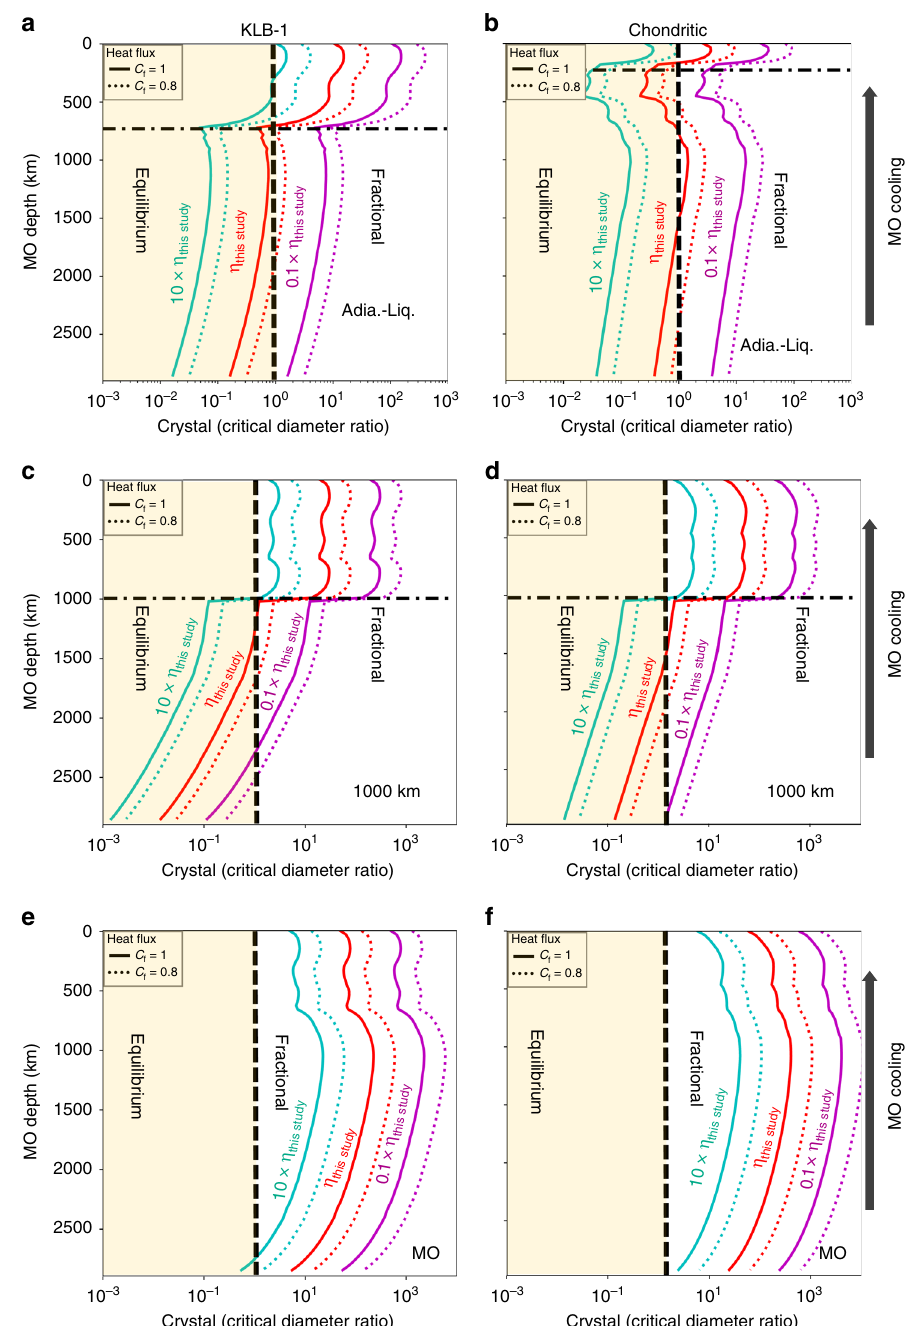
Fig. 4 Crystal/critical diameter ratio as a function of magma ocean depth. Rcc parameter calculated for KLB-1 MO ( a , c , e ) and chondritic-type MO ( b , d , f ) using bridgmanite as solid phase and a solid-melt Fe partition coef fi cient of 0.6. We considered MO viscosities of 10 (green), 1 (red), and 0.1 (blue) times the MO viscosity determined in this study. Solid or dotted pro fi les correspond to no blanketing atmosphere ( Cf = 1) or an atmosphere reducing the effective surface temperature by 20% ( Cf = 0.8, see Eq. (16)), respectively. Zones colored in yellow (Rcc lower than 1) or white (Rcc higher than 1) indicate MO expected to solidify at chemical equilibrium or through fractional solidi fi cation with sedimentation of bridgmanite, respectively. The horizontal black dashed-dotted line marks the MO-bottom depth when crystallization starts at the surface of the MO. Upper, middle and lower frames consider a crystallization zone that extends from the MO bottom to ( a , b ) the intersection of adiabatic and liquidus pro fi les (Adia.-Liq.; see situation (3) in the main text), ( c , d ) 1000 km above MO bottom, ( e , f ) MO surface, length to generate pressures up to ~30 GPa, corresponding to ~800 km depths on the P - V - T equation of state (EoS) of MgO 41 . The role of the diamond powder in the Earth ’ s mantle. Pressure medium was Cr 2 O 3 -doped MgO octahedron of is to prevent the MgO grain growth. To determine accurate sample pressure, we 10-mm edge length with edges and vertexes truncated (Supplementary Fig. 1a). used an MgO volume recorded as close as possible from the thermocouple. The polycrystalline sample was loaded in a graphite capsule. Thermocouple Pressure uncertainty is estimated to be less than 1 GPa, including the propagation (W 97 Re 3 -W 75 Re 25 ) was placed below the graphite capsule. We used MgO mixed of uncertainties on determination of MgO volume, temperature (see below) and with 10 wt% diamond (with ~1 μ m grain size) as internal pressure marker, based the EoS itself.